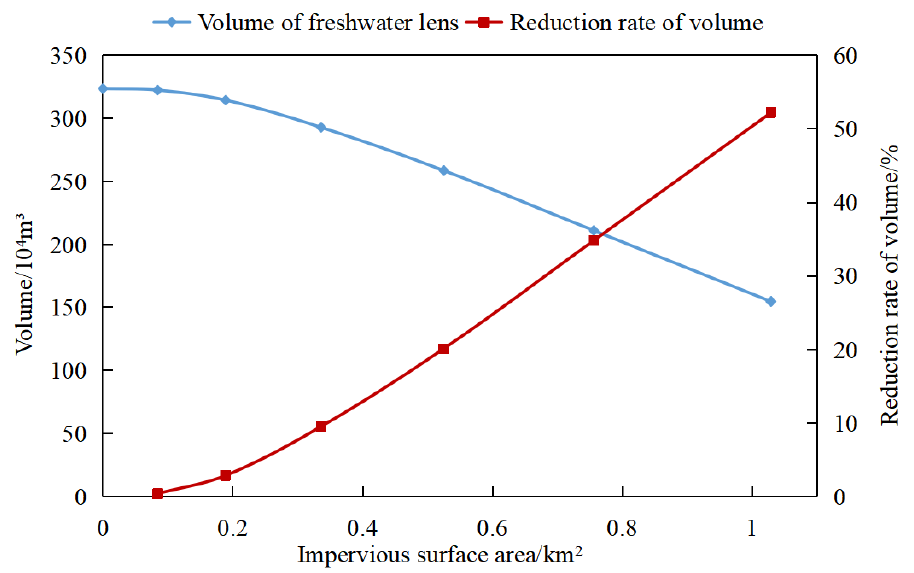
Figure 11. Variation in volume and volume reduction rate of the freshwater lens with the imperme- able surface area.